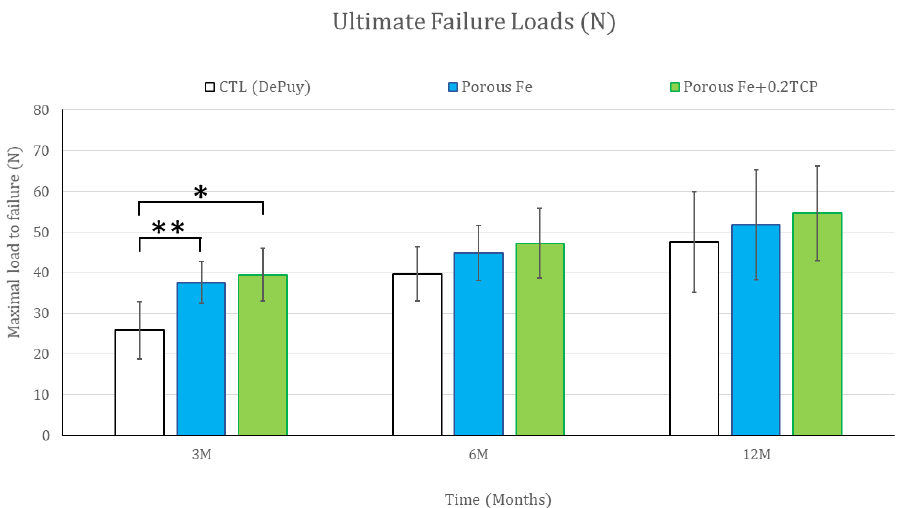
Figure 3. Ultimate failure loads of the bone–tendon–screw complex in vivo. Ultimate failure loads in all study groups increased incrementally throughout the study period. They were significantly higher in the iron_IS and TCP_IS groups than in the control group 3 months after implantation ( p = 0.0025 and 0.026, respectively). Error bars represent standard deviations. * and ** denote significant differences between groups. Table 2. Ultimate failure loads (N) of the bone–tendon–screw complex.